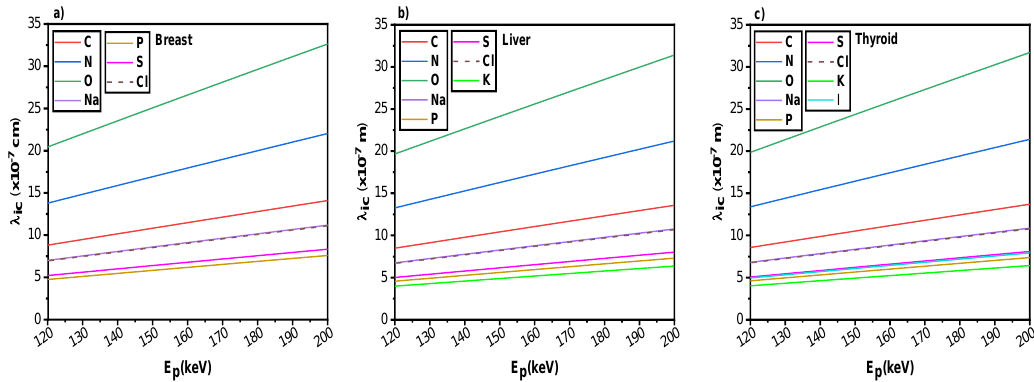
Figure 5: Inelastic core mean free path as a function of positron energy for (a) breast, (b) liver, and (c)